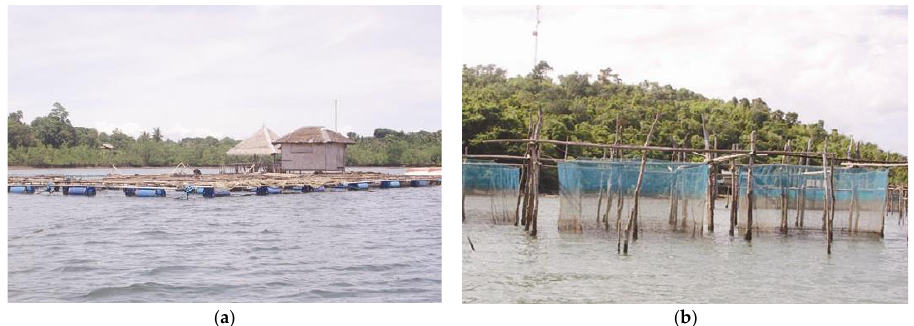
Figure 1. Floating ( a ) and fixed ( b ) cages in Palawan.